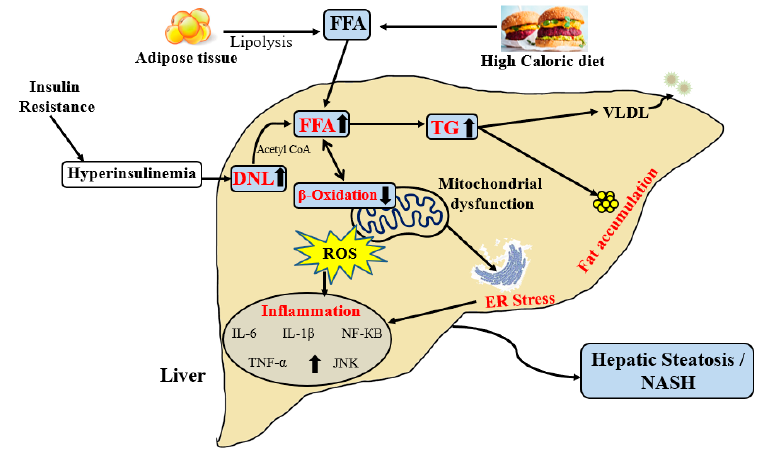
Figure 1. Pathogenesis of NAFLD. Enhanced visceral adipose tissue lipolysis, hepatic DNL, and high- caloric diet contribute to lipid accumulation in the liver. NAFLD: non-alcoholic fatty liver disease; FFA: free fatty acid; VLDL: Very low-density lipoprotein; DNL: de novo lipogenesis; ER: endoplasmic reticulum; ROS: reactive oxygen species; TNF- α : tumor necrosis factor- α ; NF-KB: nuclear factor-KB, IL: Interleukin; JNK: c-jun N terminal